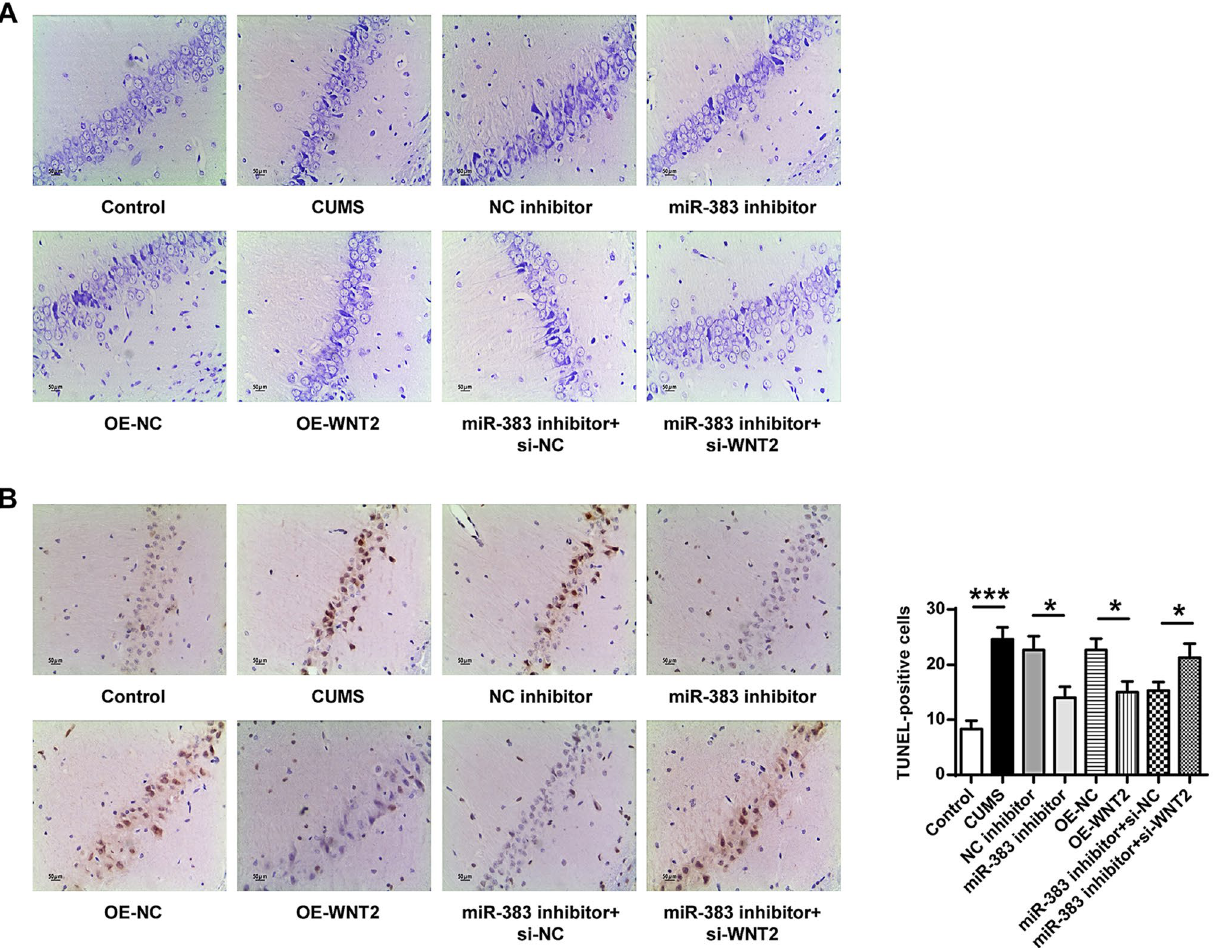
Figure 4. Downregulation of miR-383 or upregulation of Wnt2 attenuated cell injury and apoptosis rate of hippocampal neurons in CUMS-induced rats. ( A ) Images of Nissl’s staining in rat hippocampi tissues of different groups. Magnification, × 200; scale bar = 50 μm. ( B ) The apoptosis of rat hippocampal neurons of different groups was detected by TUNEL staining. Magnification, × 200; scale bar = 50 μm. N = 6. Data were presented as mean ± SD and each experiment was repeated three times. * P < 0.05, *** P < t = 4.447, P = 0.011). These results demonstrated that downregulation of miR-383 or upregulation of Wnt2 could significantly increase the expression levels of GFAP in hippocampal tissues of CUMS-induced rats. Downregulation of miR‑383 or upregulation of Wnt2 increased the expression levels of CREB, BDNF and Bcl‑2, and decreased the expression levels of Bax. Moreover, the mRNA level of CREB (Fig. 6A) and the protein level of p-CREB (Fig. 6C) in the hippocampal tissues of rats were evaluated. The results showed that the mRNA level of CREB and the protein level of p-CREB were decreased in other groups compared with that in the control group (mRNA level: CUMS vs Control, ANOVA, F (7,40) = 14.784, P = 0.000; LSD test, t = 7.846, P = 0.001; NC inhibitor vs Control, ANOVA, F (7,40) = 14.784, P = 0.000; LSD test, t = 6.836, P = 0.002; OE-NC vs Control, ANOVA, F (7,40) = 14.784, P = 0.000; LSD test, t = 7.543, P = 0.002; miR-383 inhibi- tor + si-WNT2 vs Control, ANOVA, F (7,40) = 14.784, P = 0.000; LSD test, t = 6.832, P = 0.002. Protein level: CUMS vs Control, ANOVA, F (7,40) = 15.949, P = 0.000; LSD test, t = 6.234, P = 0.003; NC inhibitor vs Control, ANOVA, F (7,40) = 15.949, P = 0.000; LSD test, t = 6.604, P = 0.003; OE-NC vs Control, ANOVA, F (7,40) = 15.949, P = 0.000; LSD test, t = 6.568, P = 0.003; miR-383 inhibitor + si-WNT2 vs Control, ANOVA, F (7,40) = 15.949, P = 0.000; LSD test, t = 5.398, P = 0.006). Compared to the control group, the expression levels of CREB were reduced in the CUMS group (ANOVA, F (7,40) = 15.949, P = 0.000; LSD test, t = 6.234, P = 0.003). Compared with the NC inhibitor group, the expression levels of CREB were increased in the miR-383 inhibitor group (ANOVA, F (7,40) = 15.949, P = 0.000; LSD test, t = − 4.509, P = 0.011). Compared to the OE-NC group, the expression levels of CREB were enhanced in the OE-Wnt2 group (ANOVA, F (7,40) = 15.949, P = 0.000; LSD test, t = − 5.500, P = 0.005). Compared to the miR-383 inhibitor plus si-NC group, the expression levels of CREB were lowered in the miR-383 inhibitor plus si-Wnt2 group (ANOVA, F (7,40) = 15.949, P = 0.000; LSD test, t = 3.818, P = 0.019). The expression of BDNF was similar to CREB in hippocampi tissues of rats in different groups (Fig. 6B,D). In addition, the protein expres-